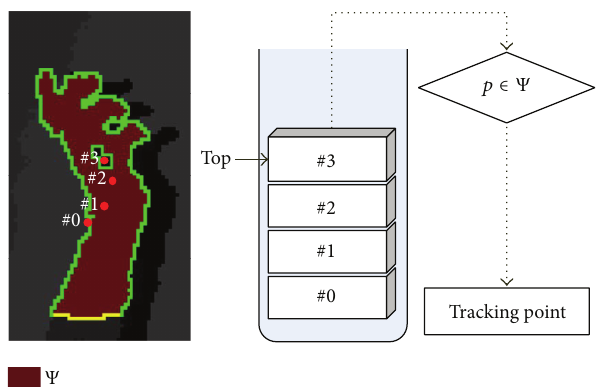
Figure 10: Decision process for tracking point.